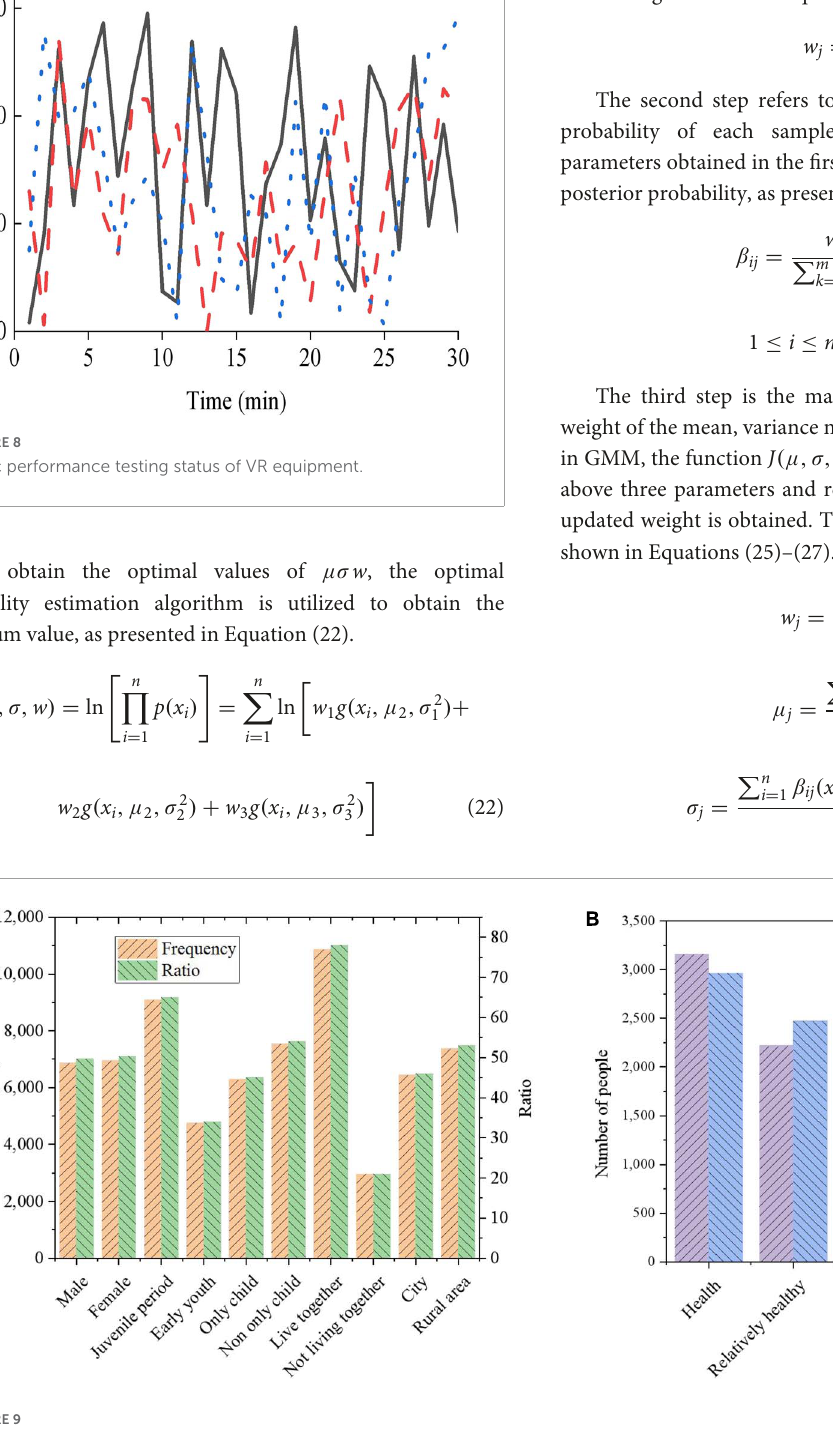
FIGURE9 Comparison of mental health status of adolescents with different genders. (A) Demographic information; (B) mental health status of adolescents by